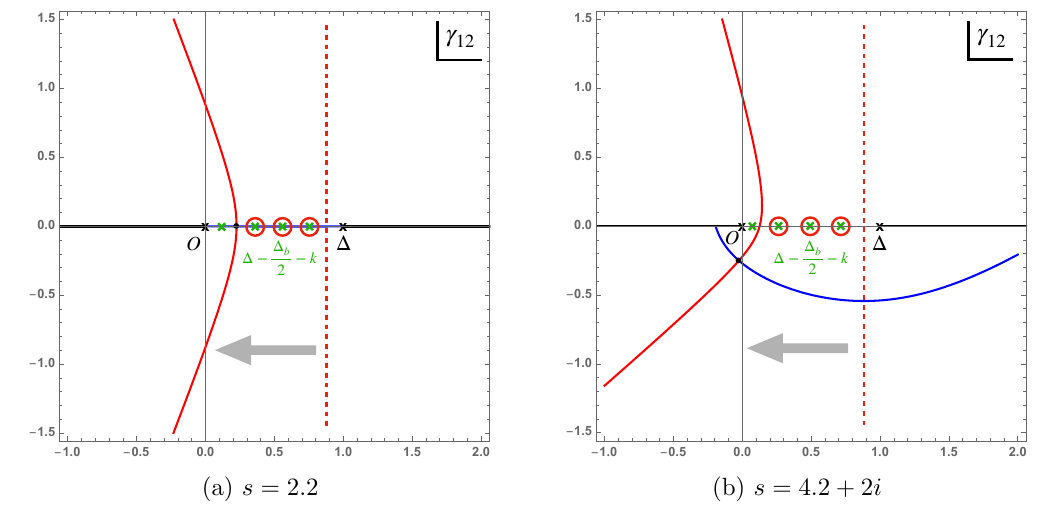
Figure 16. Steepest descent (red curve) and ascent (blue curve) contours of scalar exchange diagram with m = 1 , s = 2 . 2 (left) or s = 4 . 2 + 2 i (right). The black dot is the saddle point. The red dashed line indicates the original integral contour. The green crosses are poles of the Mellin amplitude and those with a red circle are picked up during contour deformation. The black crosses are the starting poles of Γ -functions and the rest are represented by black solid